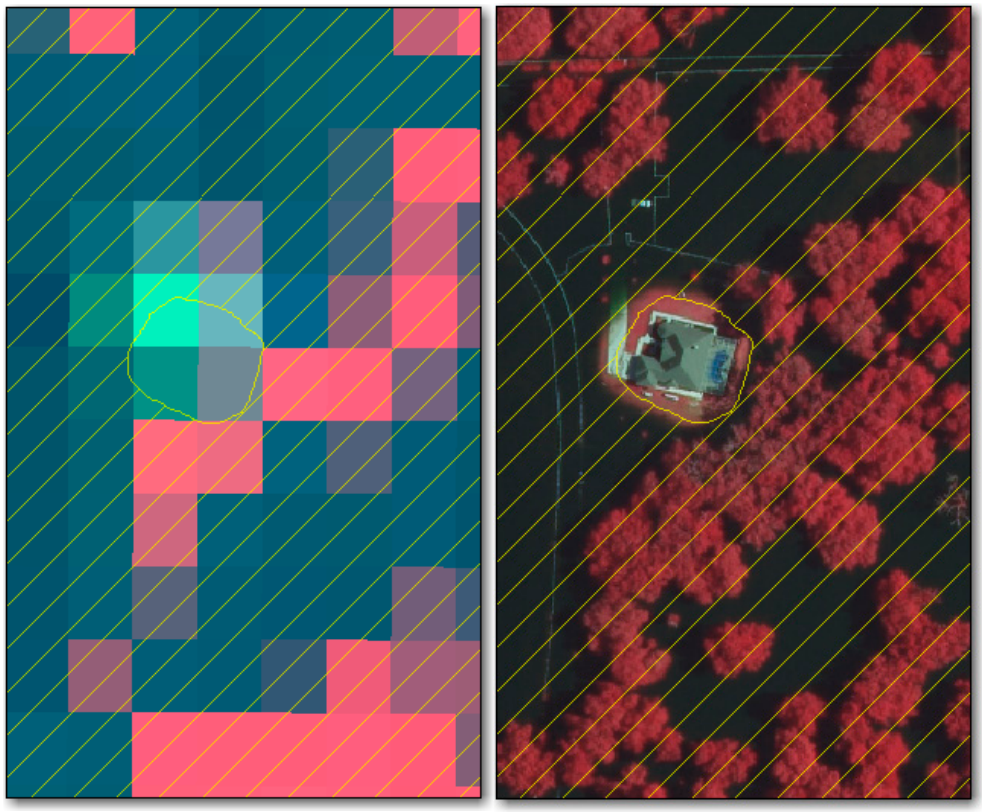
Figure 4. SPOT image ( left ) and aerial fCIR image ( right ) with modeled floodplain (yellow hatching) surrounding the house (scale ~ 1:1500).